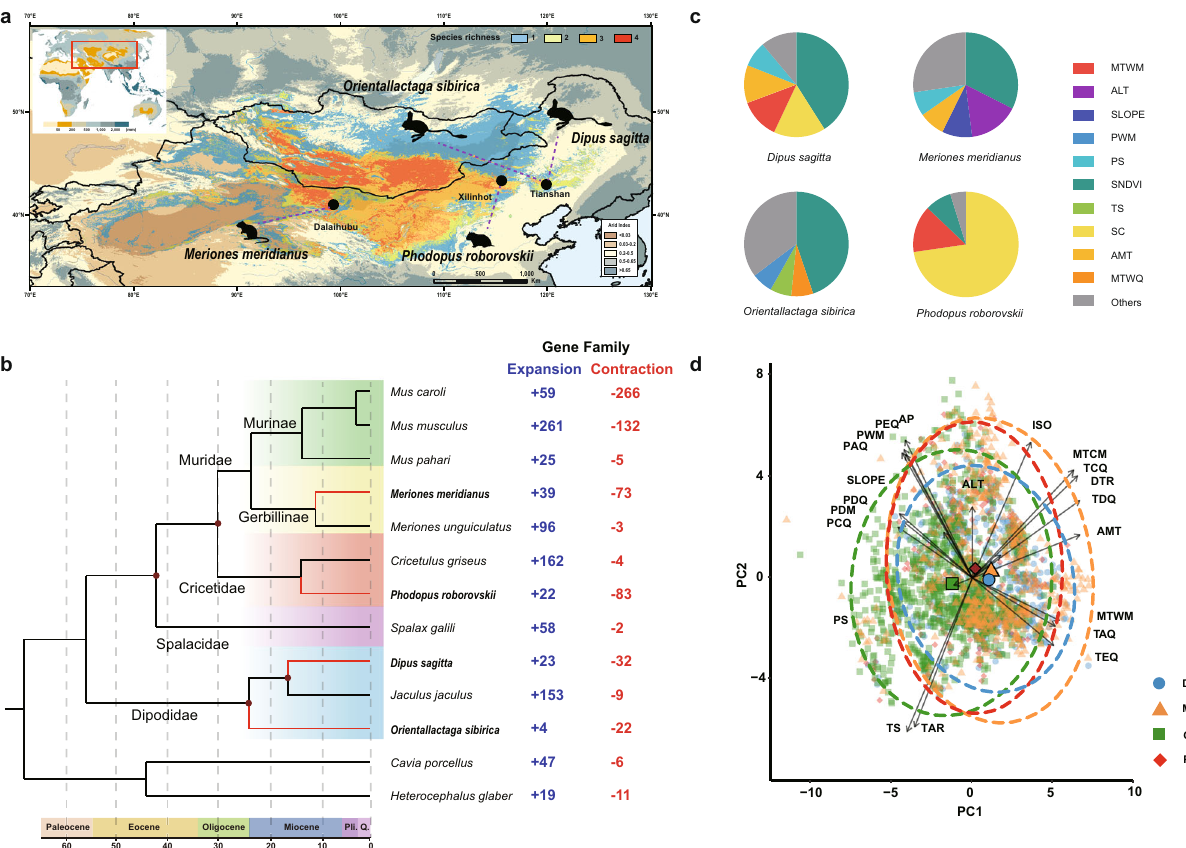
Fig. 1 Localities, phylogenetic relationships and convergent selection in ecological factors of the four desert rodents. a Sampling locations and distribution ranges of Dipus sagitta (DS), Orientallactaga sibirica (OS), Meriones meridianus (MM), and Phodopus roborovskii (PR). The base map shows the arid index. The colour representing the species richness indicates the number of species present in the current region. b Phylogenetic tree using the maximum-likelihood algorithm from 5102 single-copy orthologous groups of 13 species. Branch lengths in the tree are scaled to estimate divergence times in Mya. The tree topology is supported by posterior probabilities of 1.0 for all nodes. The numbers of signi fi cantly expanded and contracted gene families are labelled following each branch. c Contributions of environmental variable to the four species SDM in MAXENT models. The size of the color pie ratio indicates the size of the contribution value. d Scatterplot of the fi rst and second principal components of the 21 climatic parameters with 95% con fi dence eclipses clustered by species. The large colored polygons represent the centroid of each species. The environmental factors included altitude, terrain slope, and 19 climate factors. Detailed information is listed in the Supplementary Note 2.